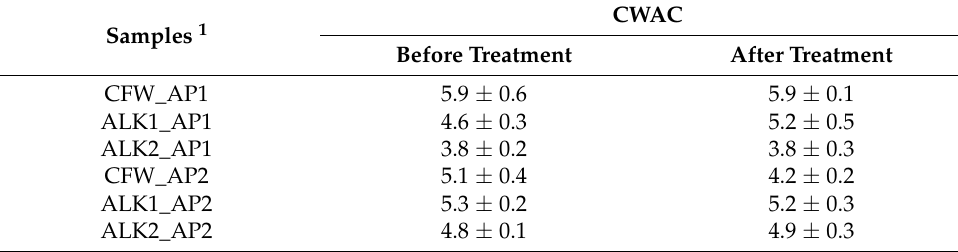
Table 2. Comparison of capillary water absorption coefficient (CWAC) before and after treatment.